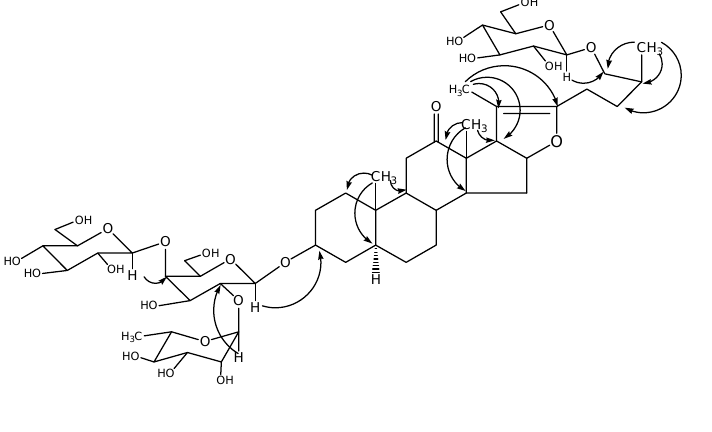
Figure 1. Structure and key HMBC correlations (H → C) compound 1